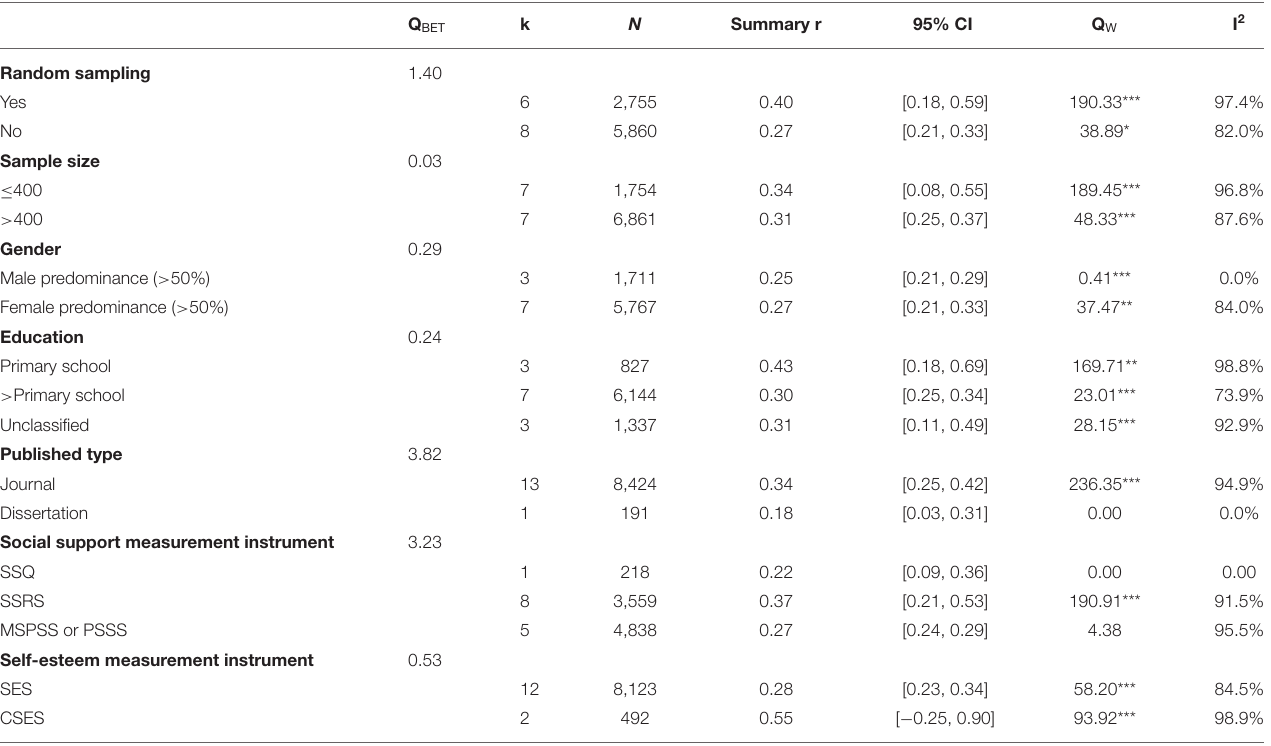
TABLE 3 | Subgroup analyses of the summary correlation between social support and self-esteem among LBC. Q BET k N Summary r 95%